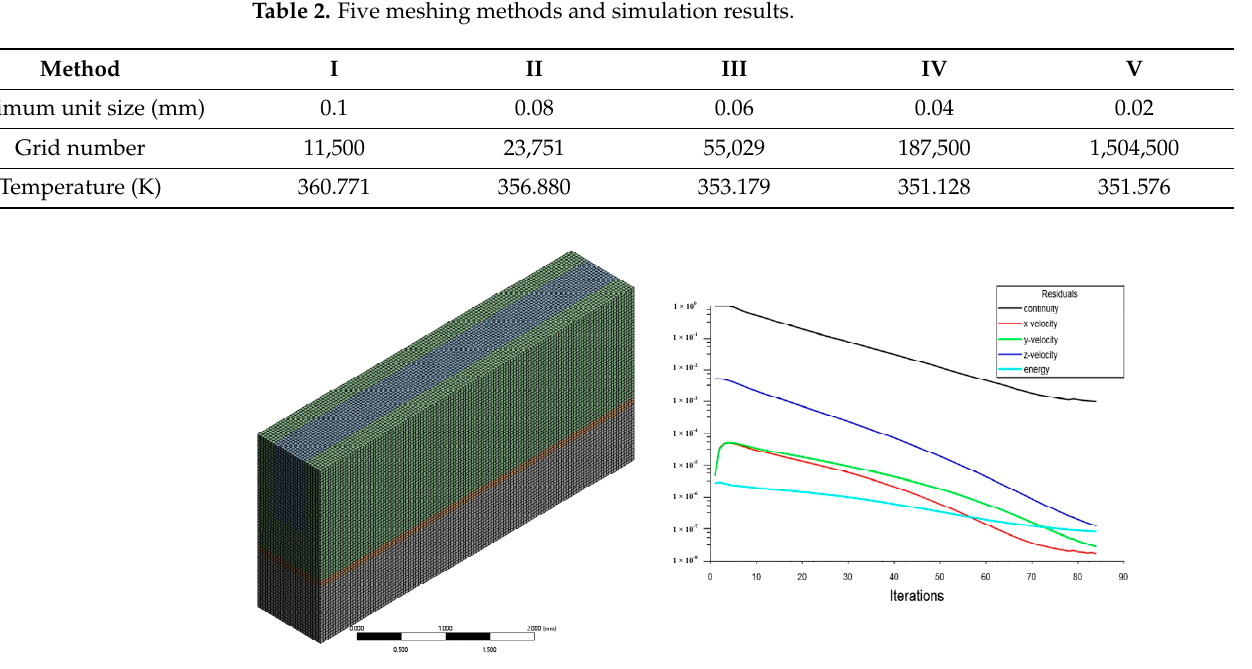
Figure 5. Comparison between numerical and experimental data. 2.4. Setup and Boundary Conditions At a reference temperature of 300 K, the kinematic viscosity of water is 8.937 × 10 − 5 m 2 /s [31]. The flow velocity was relatively uniform in the MC-R heat sink, and the Re was calculated as 2237.9 (Equations (8) and (9)); therefore, the laminar flow model was used to solve it. However, in the heat sink with special-shaped structures of MC-CR and MC- HR heat sinks, the fluid in the channels no longer maintained an orderly stratified flow, so turbulence models were used to solve it. In order to simplify the simulation setup, it was assumed that the microelectronic chip heated up uniformly. The details of the bound- ary conditions are as follows, 1. The inlet adopted velocity-inlet flow rate was 2 m/s; 2.